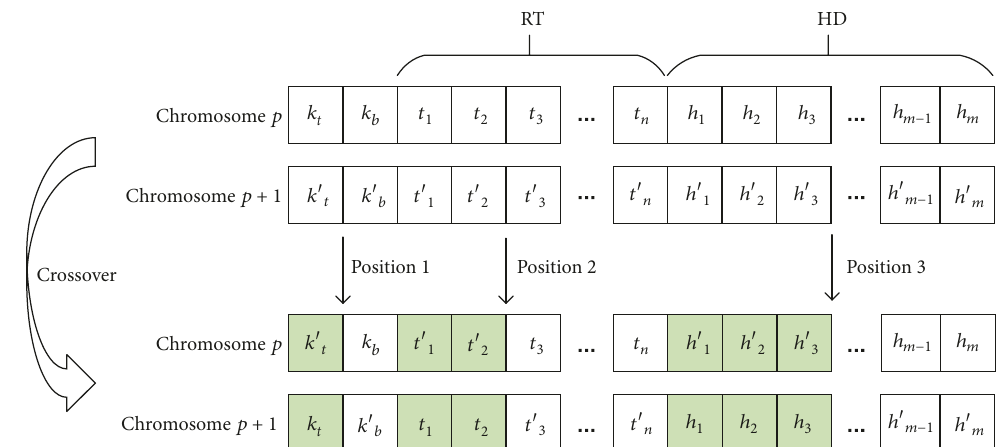
Figure 9: The structure of chromosome and crossover operation.